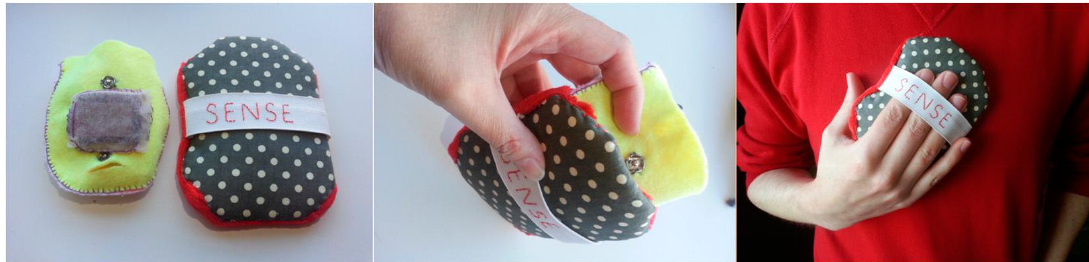
Figure 1. Props on the body as tools to shape participant’s stories.